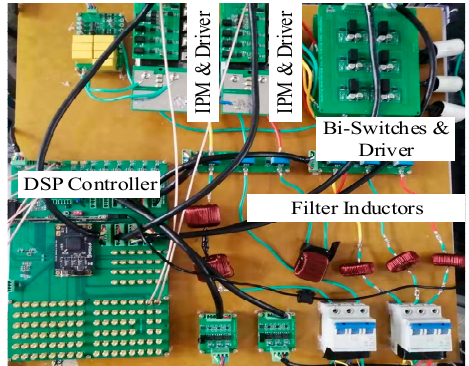
Figure 9. The H3C prototype used in the experiments. Table 2. System parameters.